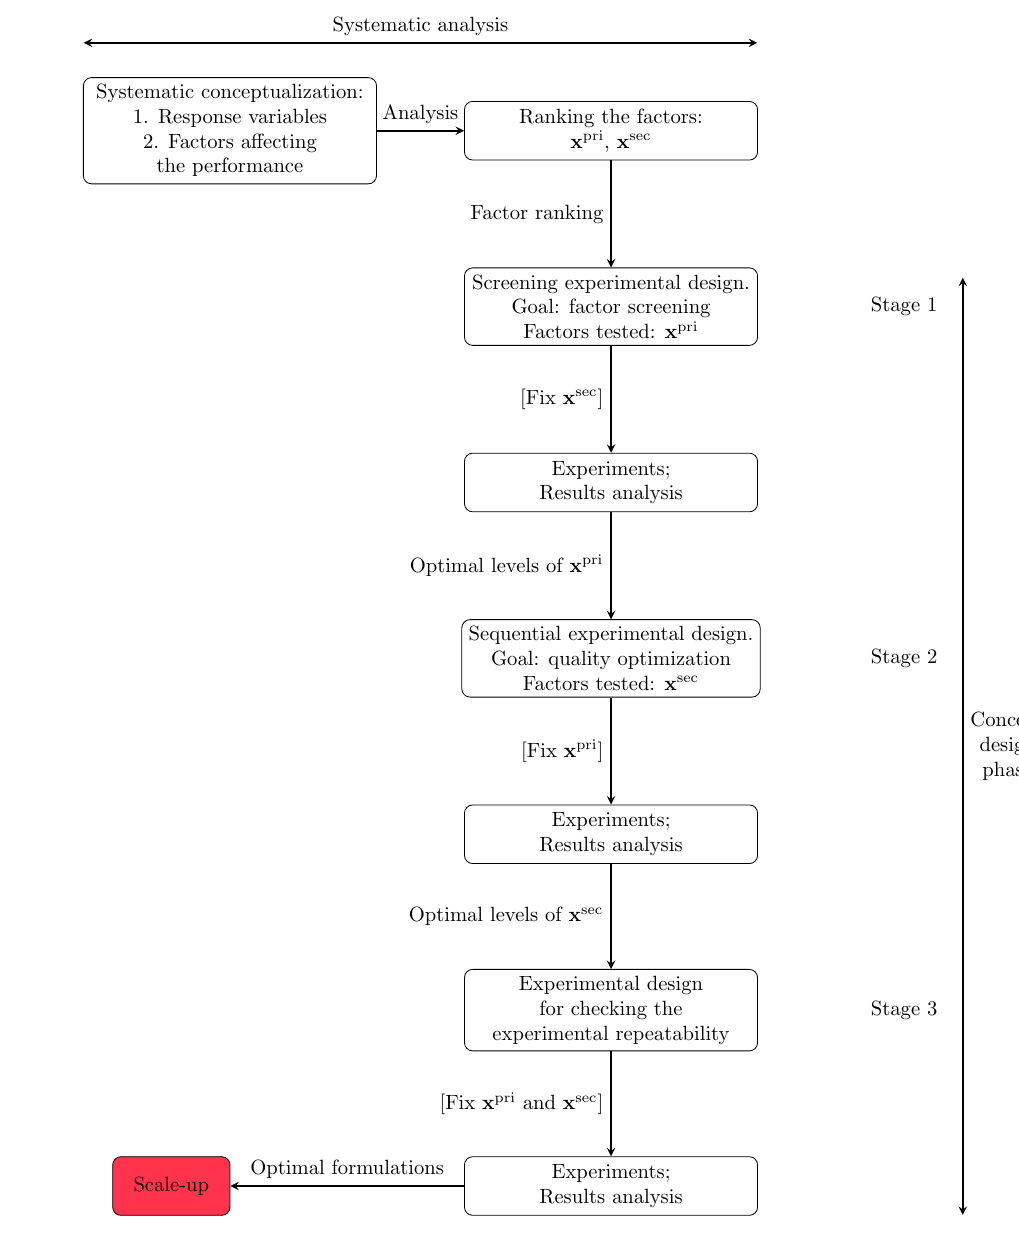
Figure 2. Systematic procedure for hierarchically organizing the experimental work in a customer- centric